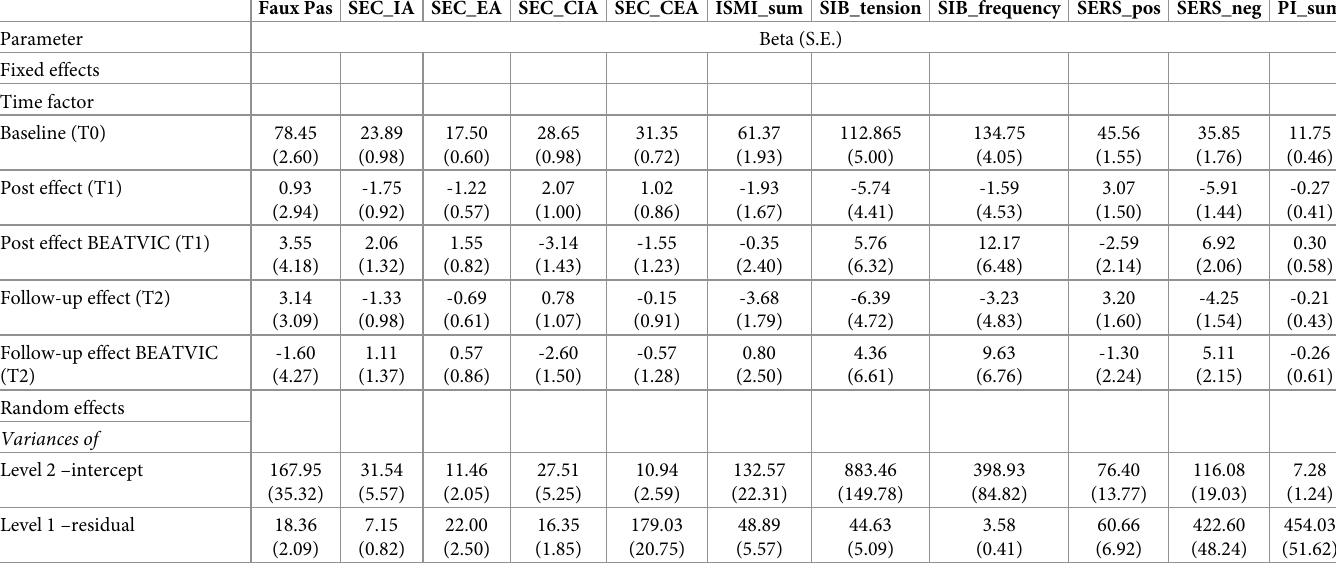
Table 4. Fixed and random effects (beta and standard error) on primary outcomes.